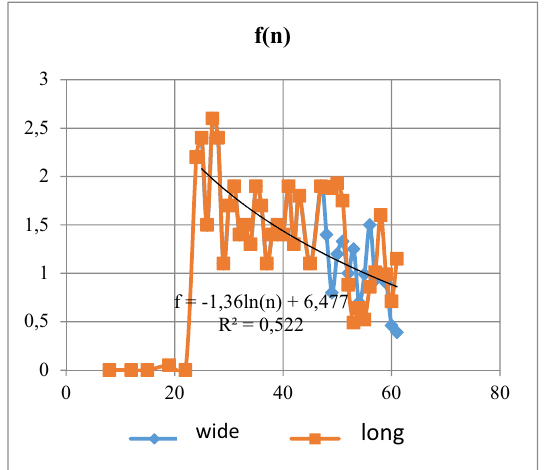
Figure. 5.1. Dependency of difference of average values of the objective function on task dimension